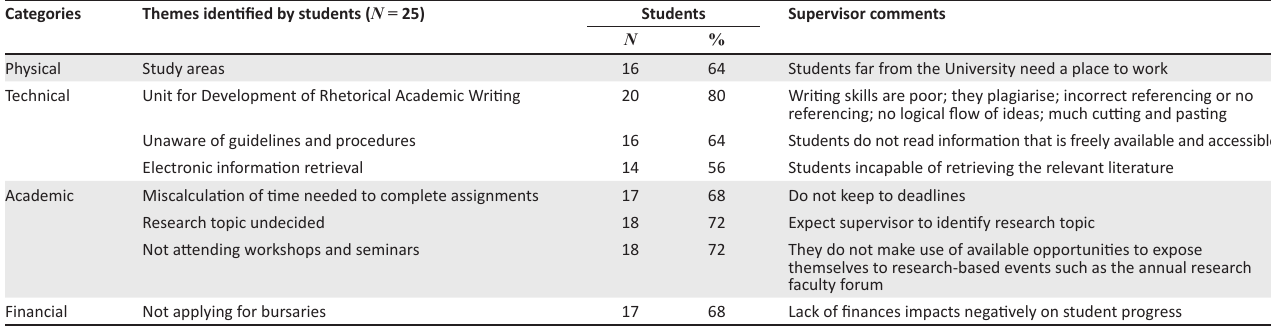
TABLE 1: Aggregate data from students and